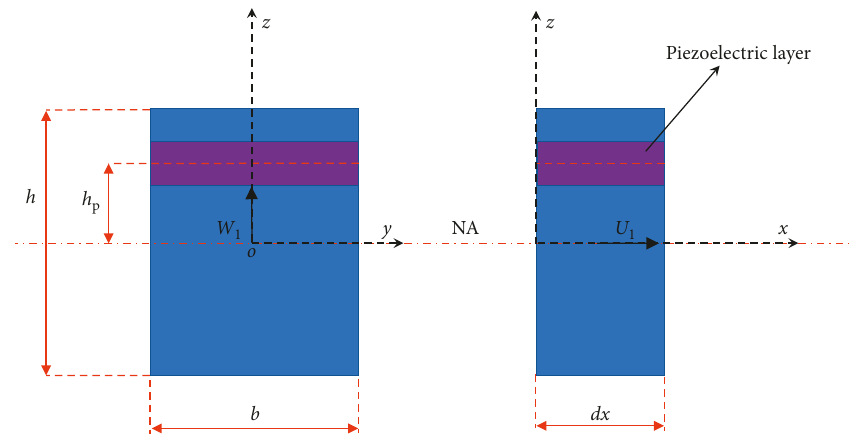
Figure 3: Schematic cross-sectional area and the distance of the piezoelectric layer from the neutral axis.